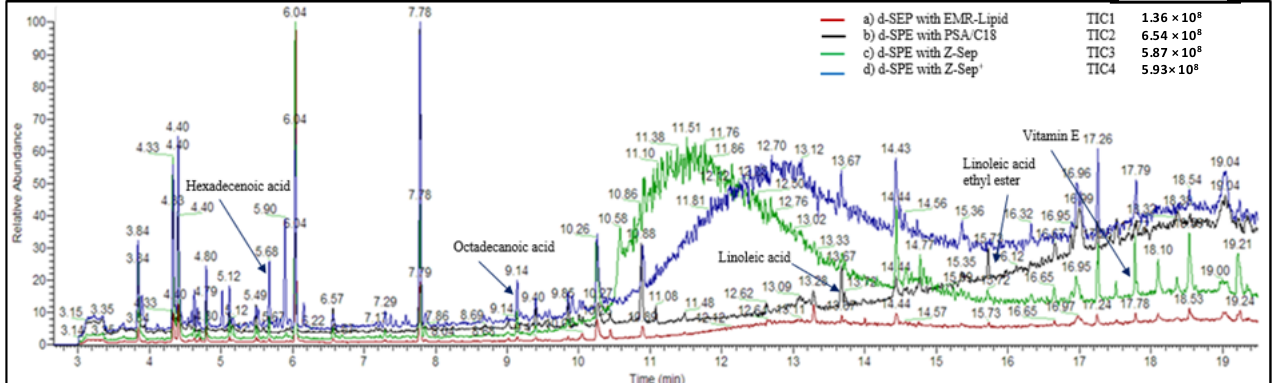
Figure 5. GC-Q-Orbitrap full scan chromatograms of rapeseed extracts using QuEChERS methodology with different d-SPE sorbents.